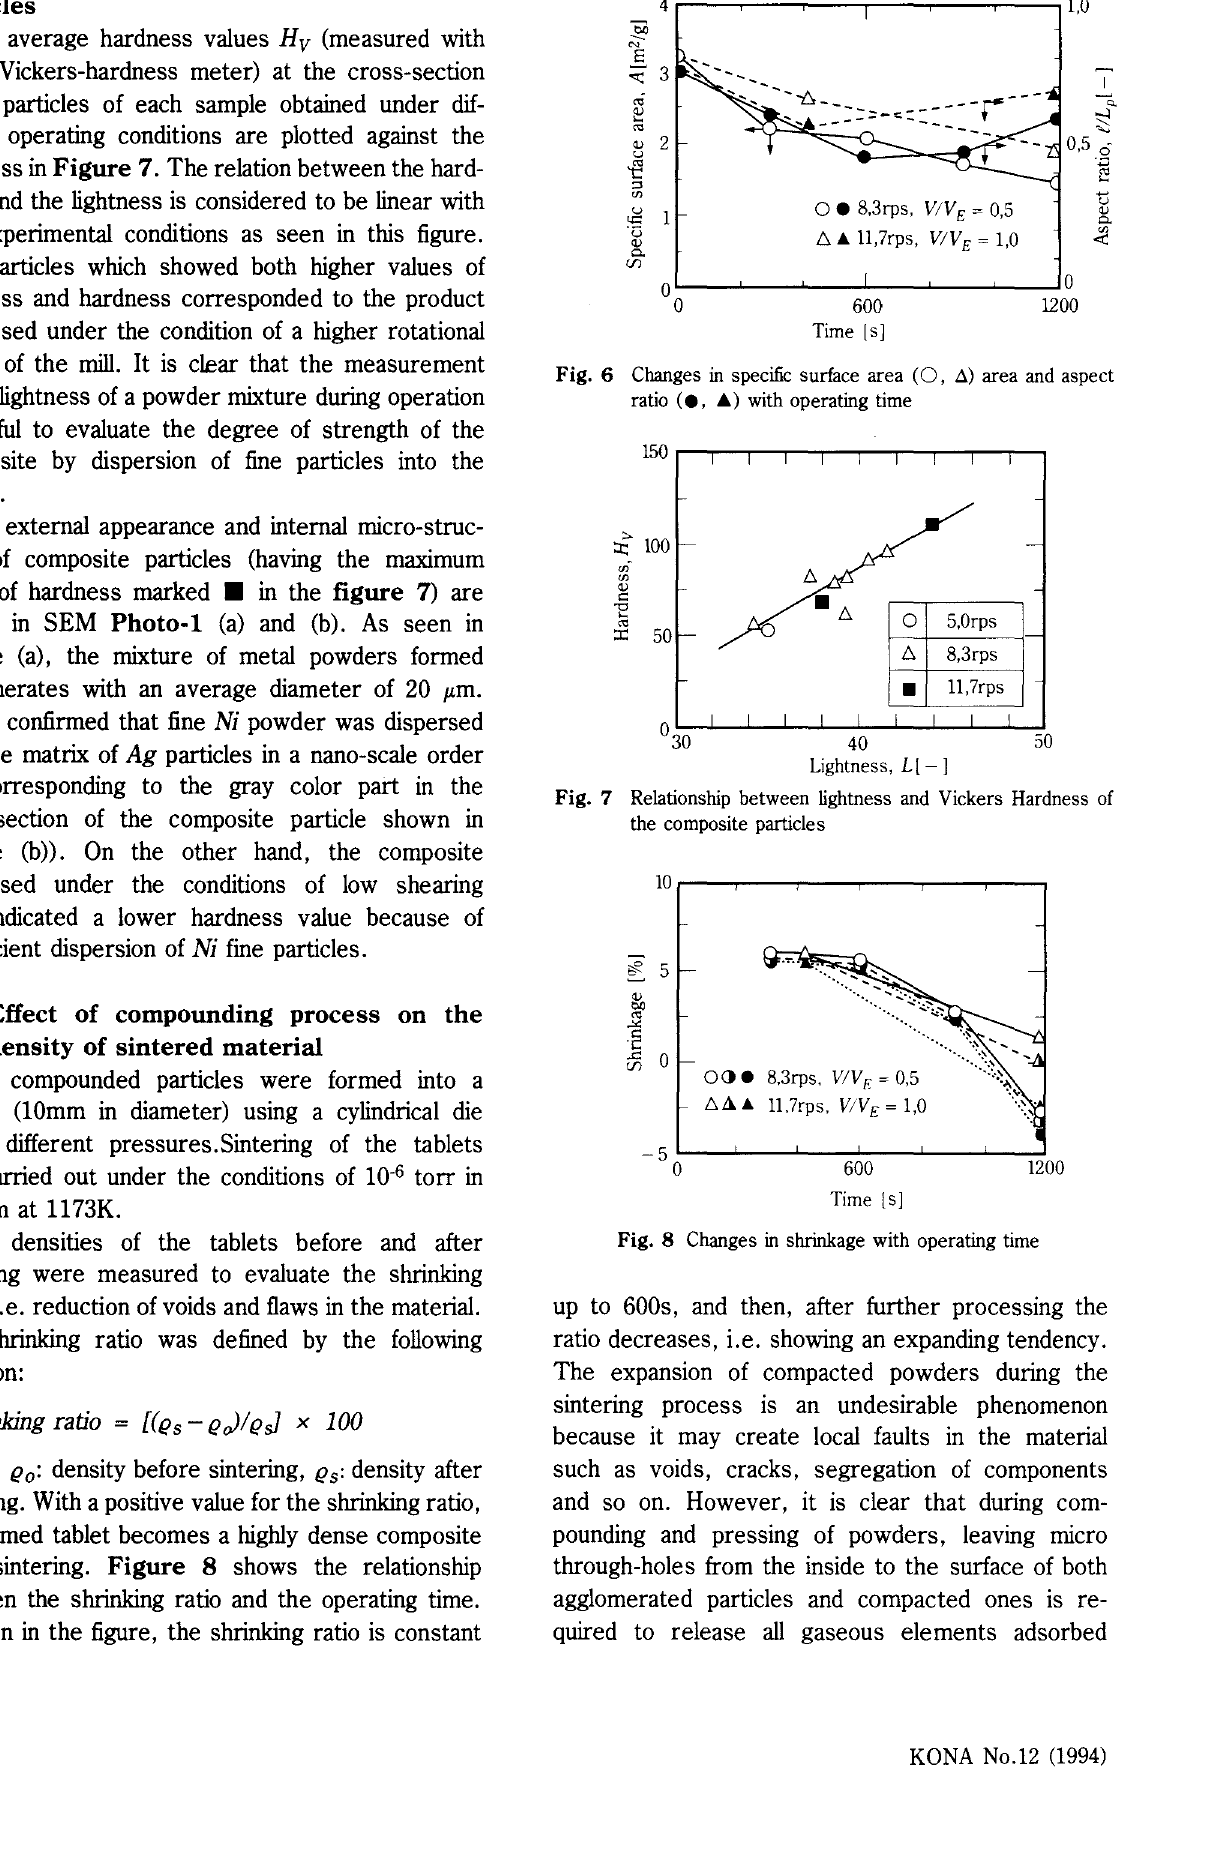
Fig. 6 Changes in specific surface area ( 0, .::l) area and aspect ratio (e, A) with operating time